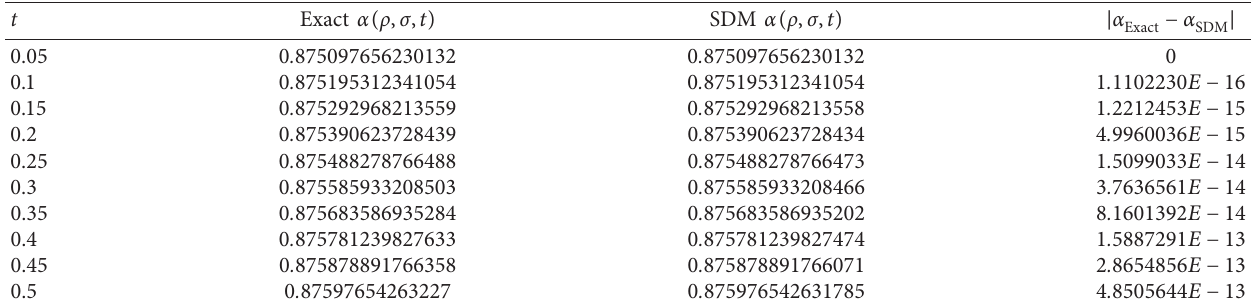
Table 2: The (SDM) results for α ( ρ , σ ,t ) for first four approximations for R � 1, with mesh points ρ � 0.1 and σ � 0.1, for Example 2.